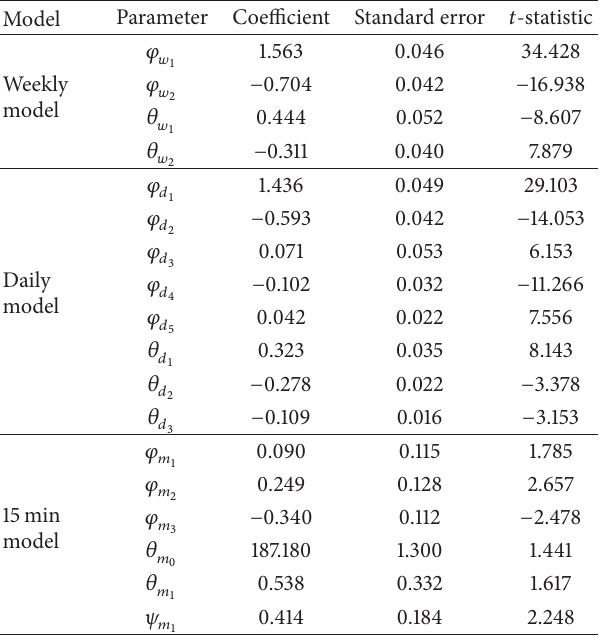
Table 2: Parameters of weekly, daily, and 15 min